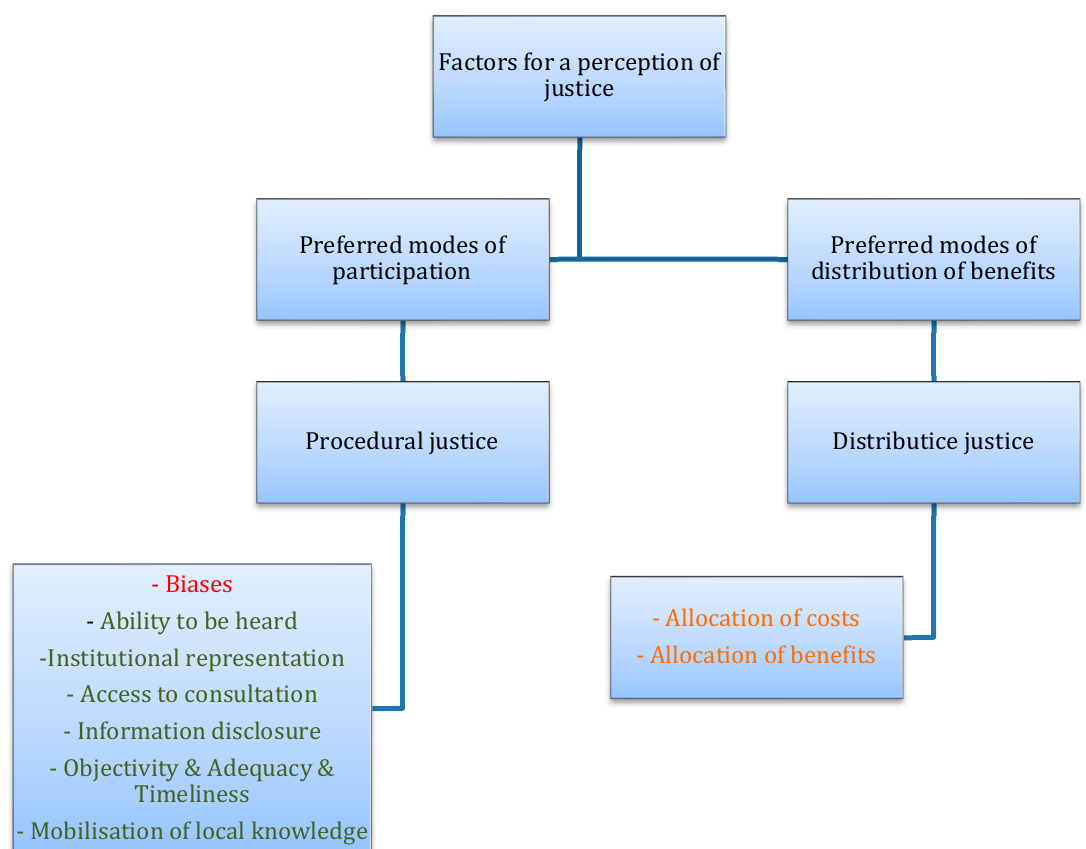
Figure 3. Tested conceptual framework. (red means this indicator is not likely to be tackled; green means this indicator can be tackled; orange means it cannot significantly be confirmed these indicators can be tackled).